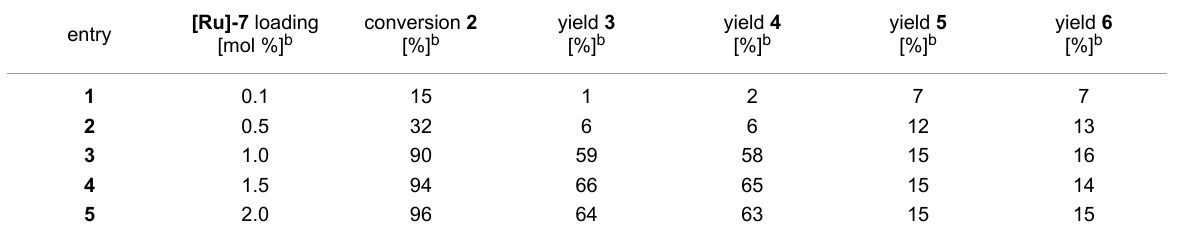
Table 2: Results of catalytic investigations of cross-metathesis of 1 with 2 with various [Ru]-7 loadings. a